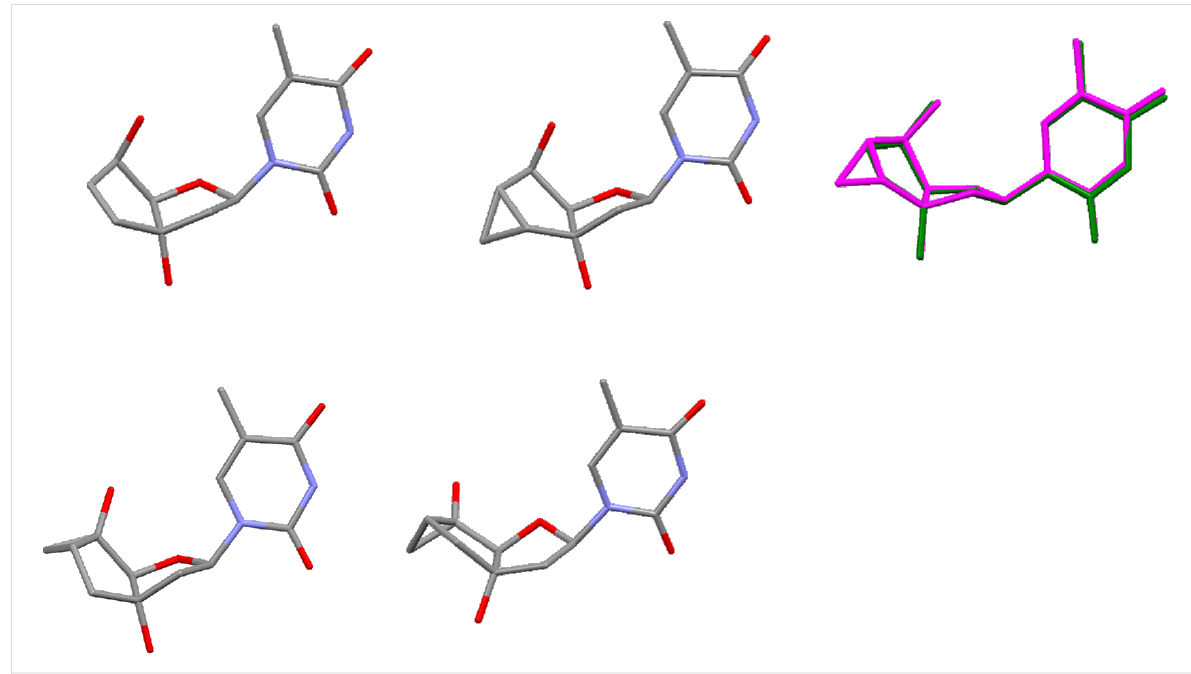
Figure 2: X-ray structure of top row: nucleosides 8 β (left), 11 β (center) and overlay of both structures (right); bottom row: tc-T (Mol A, left, Mol B, right).